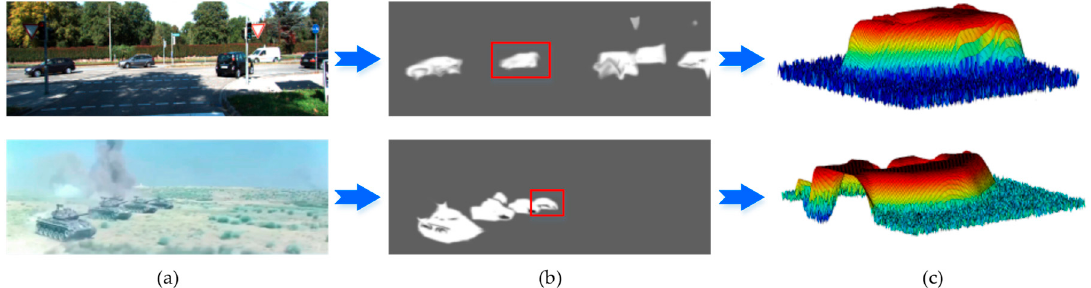
Figure 4. Example of the spatial-attention map and 3D spatial-attention value features of targets. ( a ) Input frames; ( b ) spatial-attention map; ( c ) 3D spatial-attention value features of targets.